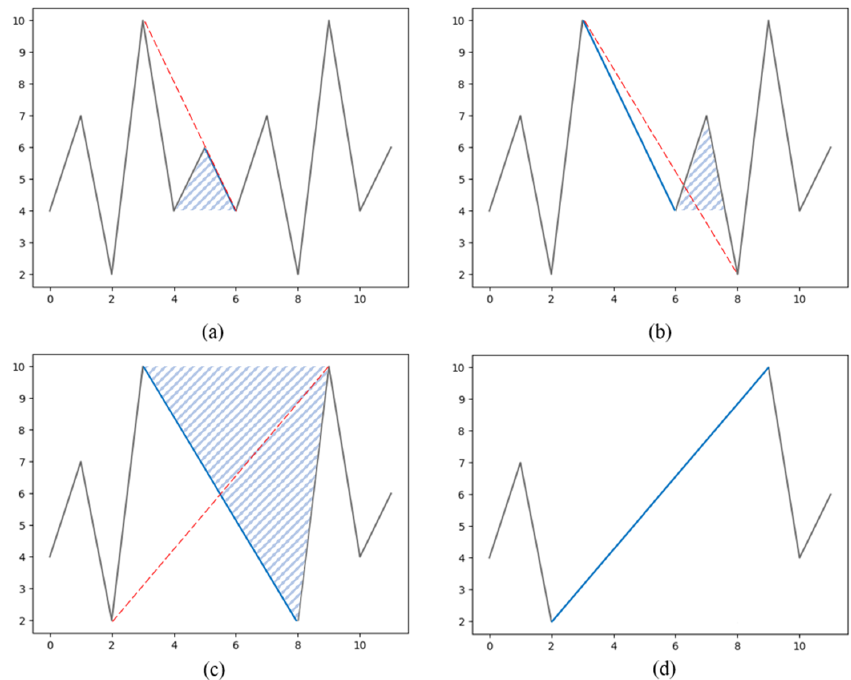
Figure A2. Example of extracting several cycles using the rainflow counting algorithm. ( a ) Extract the cycle of the blue triangle and use the red dotted line to fill the interval, the cycle depth is 2, the average is 5. ( b )Using the same method to extract cycle [4,7], depth is 3, average is 5.5. ( c ) Use the same method to extract cycle [2,10], depth is 8, average is 6. ( d ) Sequence after Extraction